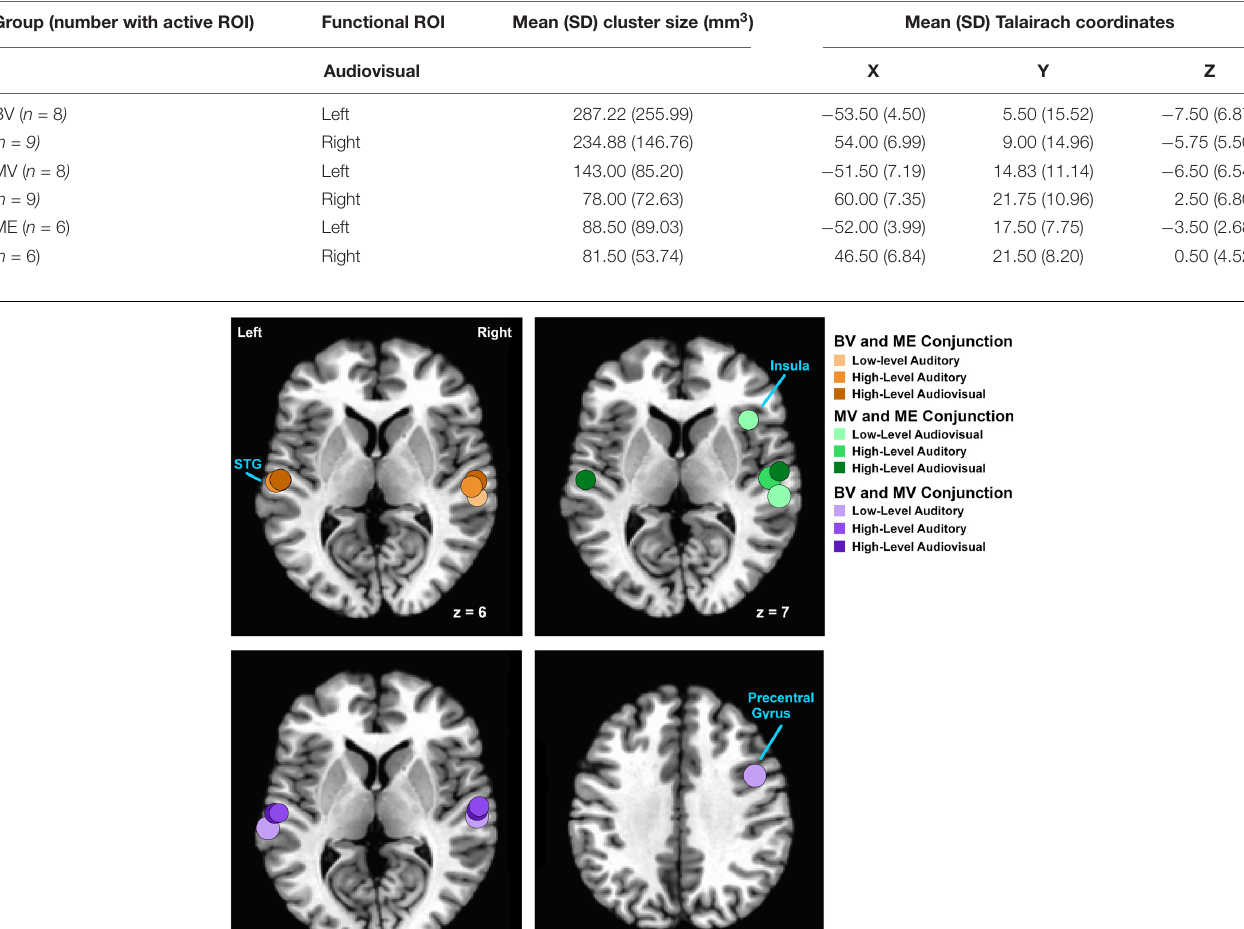
TABLE 2 | Total number of participants with active ROI, mean (SD) cluster size (mm 3 ) and mean (SD) Talairach coordinates for experiment 2: rapid event related design. Group (number with active ROI)